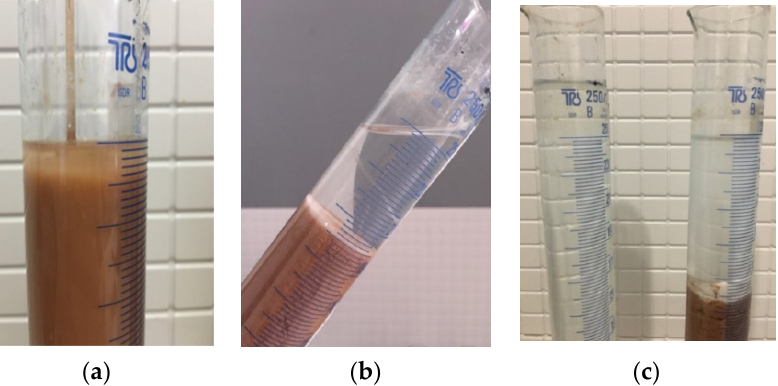
Figure 6. Verification of the coagulation properties of the obtained calcium aluminosilicate reagent sample: ( a ) deposition within 15 min, ( b ) deposition within 30 min, ( c ) comparison of pure distilled and clarified water after 45 min of settling time.